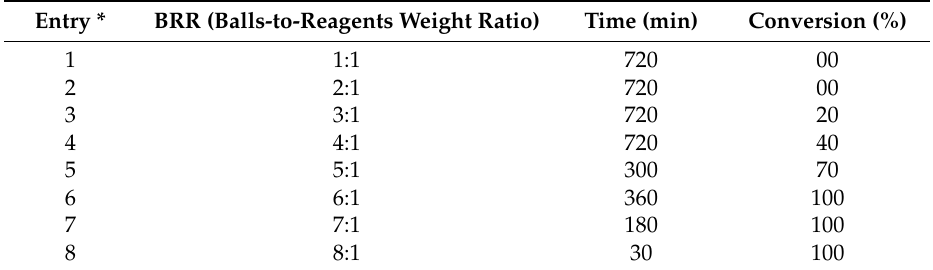
Table 1. Milling parameters and the conversion rate for the synthesis of 3,4-dihydropyrimidines derivatives.